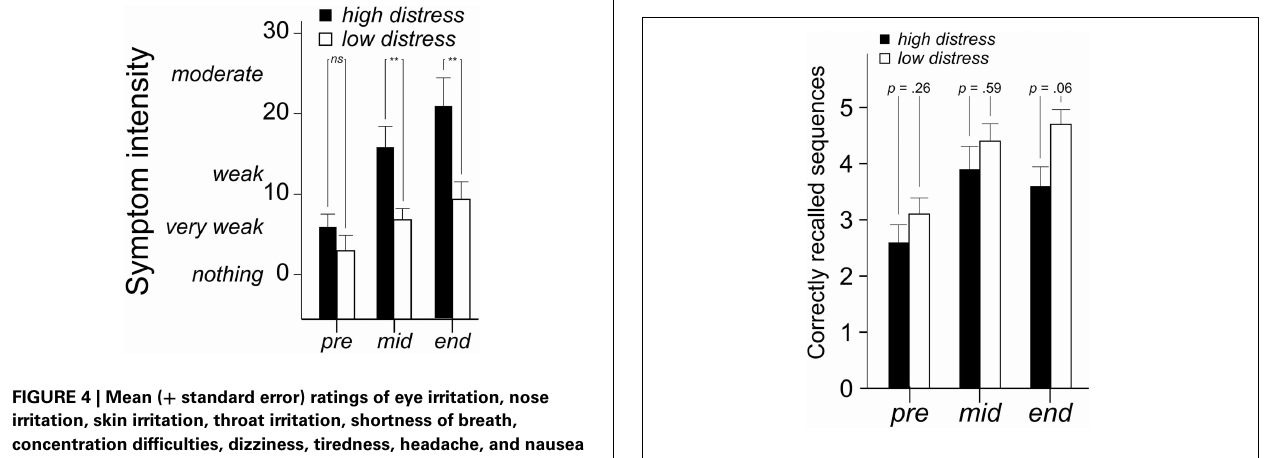
FIGURE 5 | Mean ( + standard error) number of correctly recalled sequences in the updating task. P- values refer to the ANOVA parameter